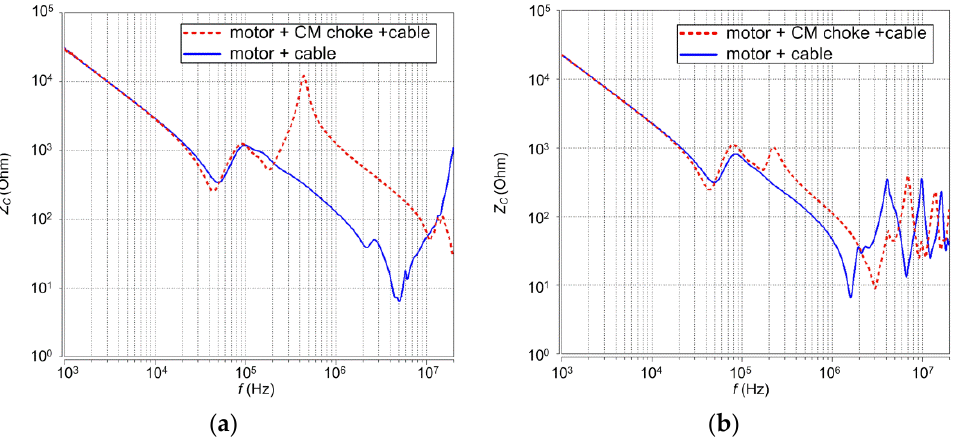
Figure 18. Measured impedance Z C (f) frequency characteristics: ( a ) motor + CM choke ( L C = 0.72 mH) + 1 m cable; ( b )